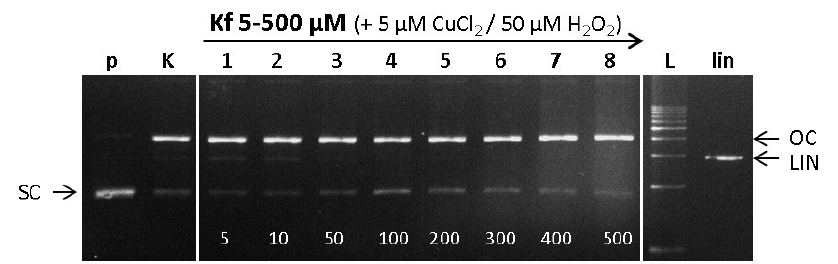
Figure 7. Electrophoretic profile of agarose gel (0.8%), 15 µ M plasmid PBSK + DNA with Cu(II) ions, hydrogen peroxide and kaempferol incubated for 30 min. Samples were loaded in the gel lanes in the following order: (p) pDNA–control; (K) pDNA + 5 µ M CuCl 2 + 50 µ M H 2 O 2 -control Cu-Fenton reaction; (1–8) pDNA + 5 µ M CuCl 2 + 50 µ M H 2 O 2 + (1) 5 µ M kaempferol, (2) 10 µ M kaempferol, (3) 50 µ M kaempferol, (4) 100 µ M kaempferol, (5) 200 µ M kaempferol, (6) 300 µ M kaempferol, (7) 400 µ M kaempferol, (8) 500 µ M kaempferol; (L) 1 kb DNA standard, (lin) pDNA linearized with EcoR1